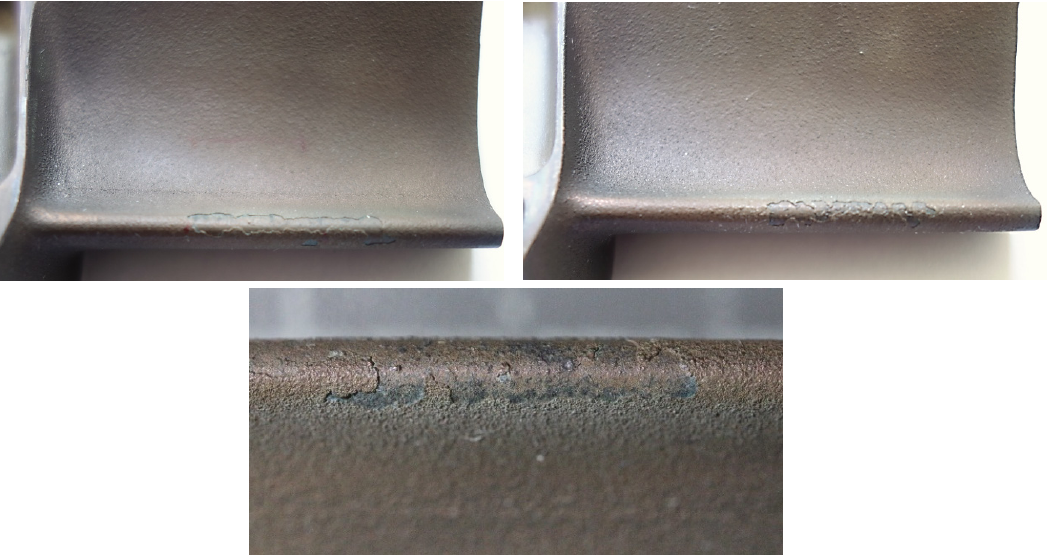
Figure 8. Macrophotographs of the leading edge of the blade with a protective coating made using the APS + SLURRY method.